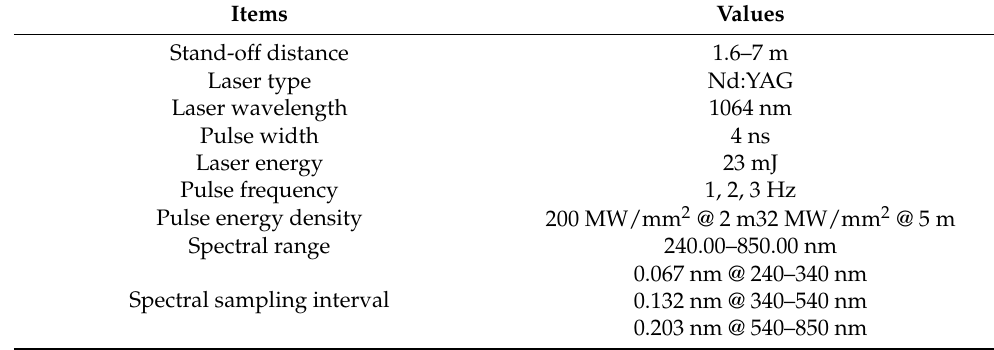
Table 1. Main parameters of MarSCoDe